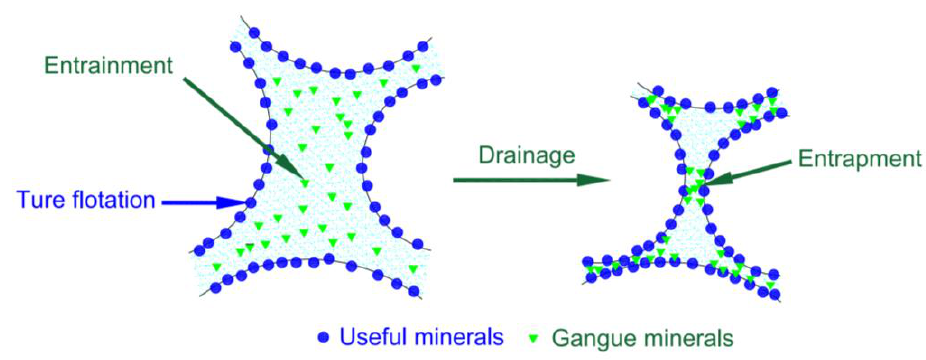
Figure 1. The schematical illustration of froth entrainment in the flotation process.